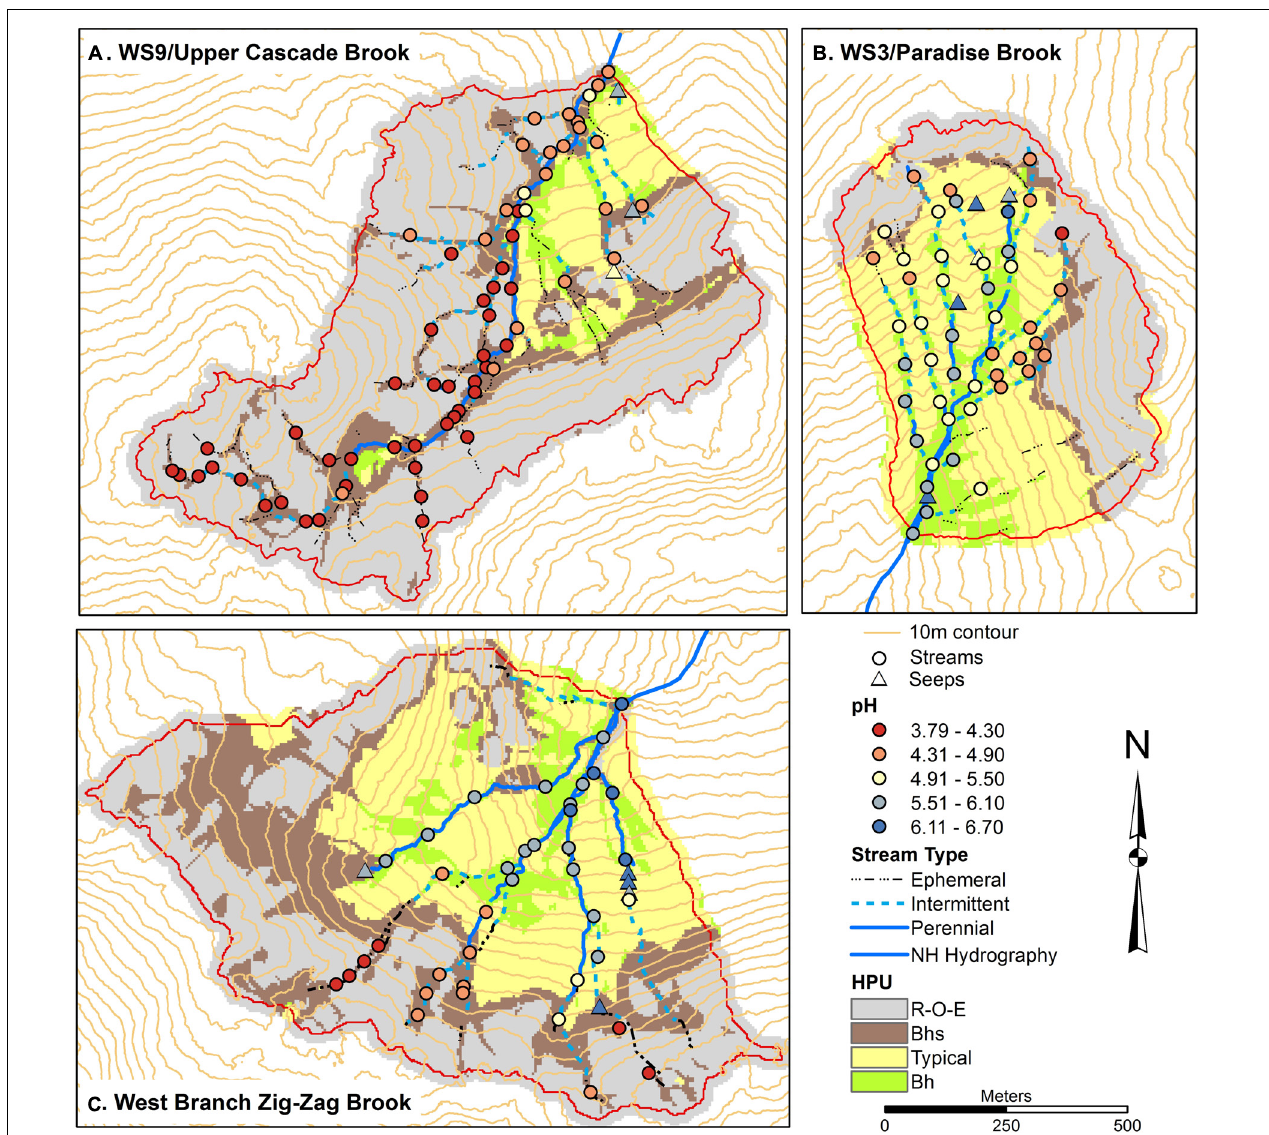
FIGURE 2 | Soils maps for W9 (A) , W3 (B) , and West Branch Zig Zag Brook (C) with variation in surface water pH from a synoptic survey conducted July 22–23, 2015. Surface water samples were classified as streams (circles) or seeps (triangles). Soil units include bedrock outcrops, bedrock Histosols, and E